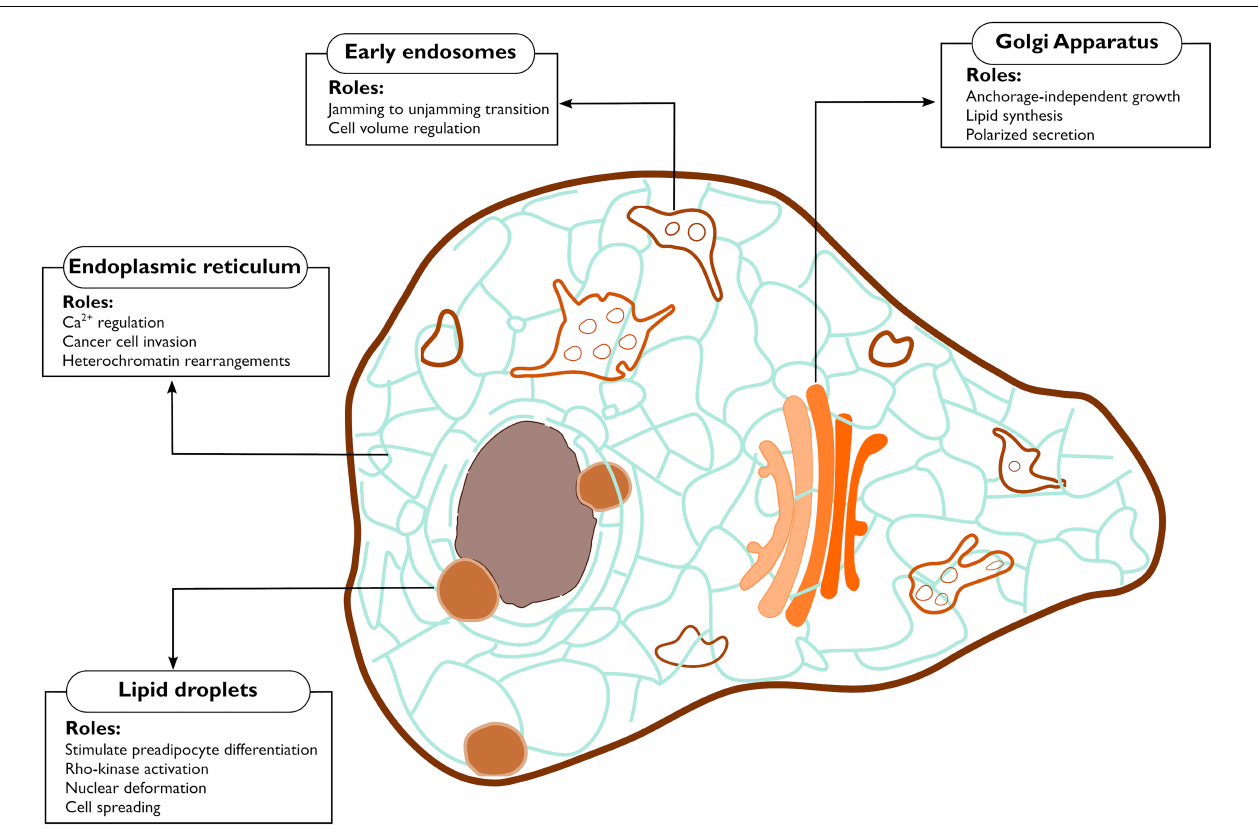
FIGURE 2 | Functions controlled by mechanical properties of the endomembranes. The figure highlights the cellular processes debated in this review that are affected by mechanical changes occurring at endomembranes.